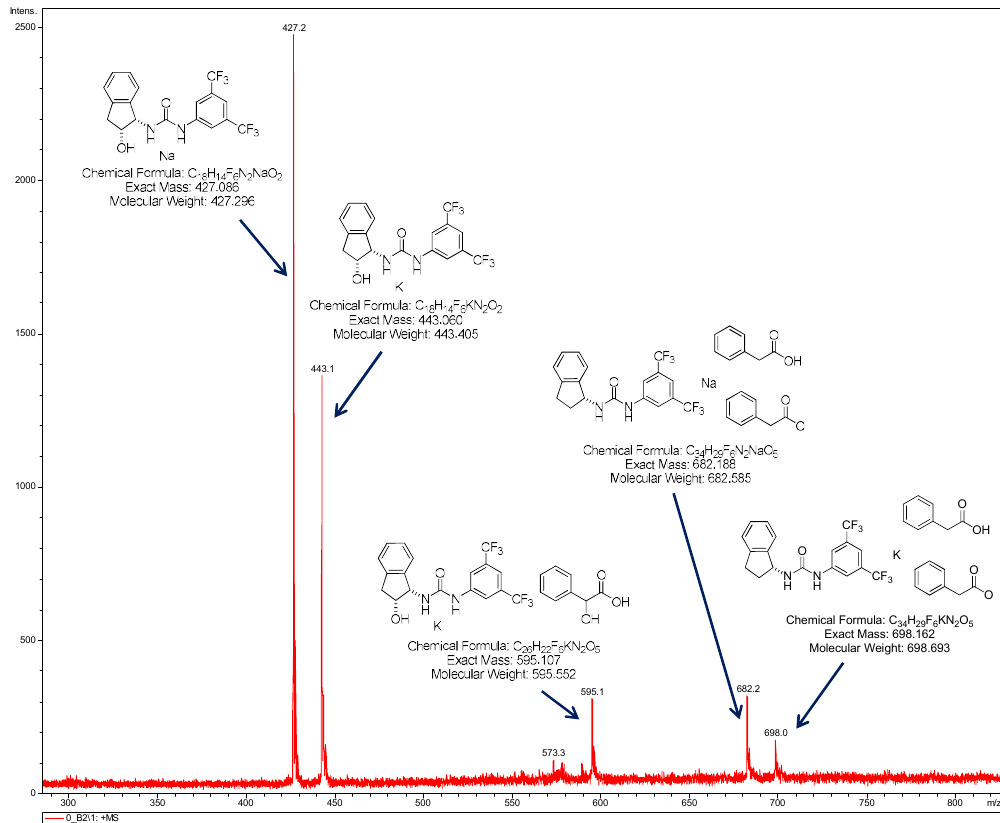
Figure 6. Cationic ESI-MS spectra experiment in CHCl 3 .